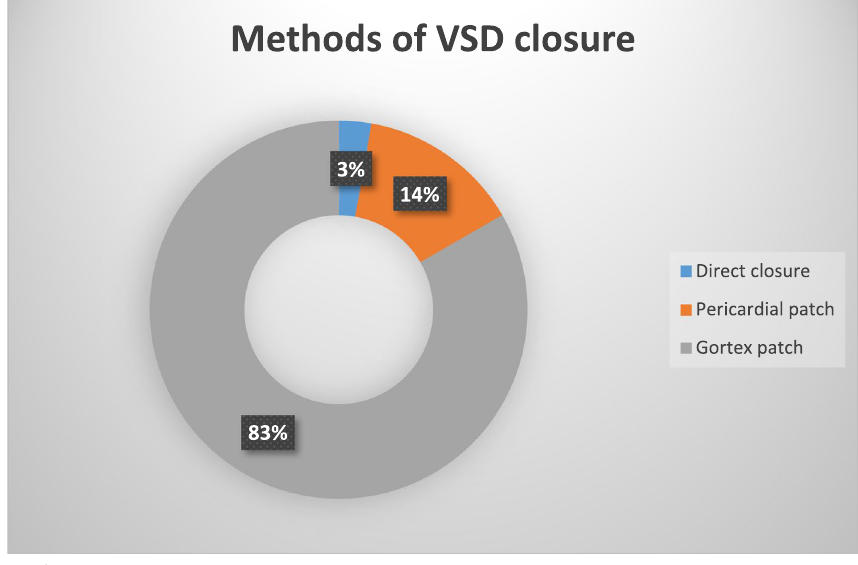
Fig. 1 Methods of VSD closure in group I